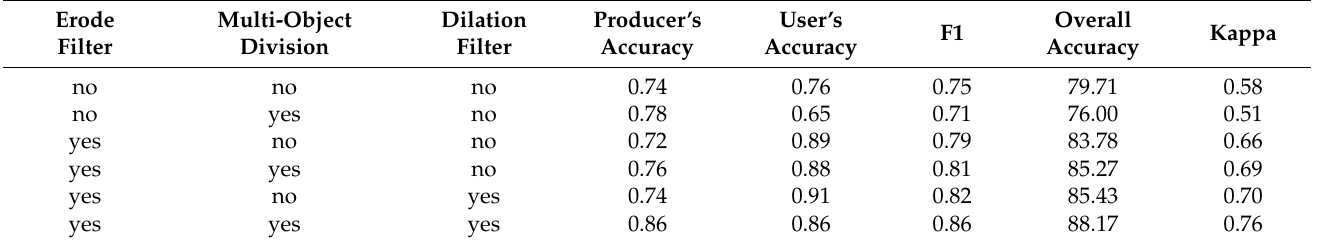
Table 4. Impact of the application of math morphology filters, and multi-object division techniques on boat detection